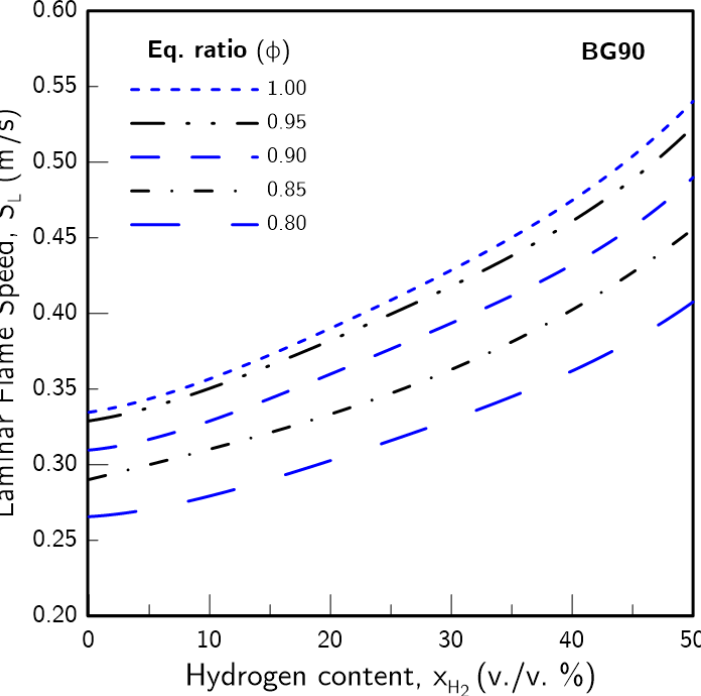
Figure 2. Laminar flame speed of BG90/air flames enriched with H the model results for a determined equivalence ratio ( φ ). Conditions were set at p = 1atm and T u = 298K.